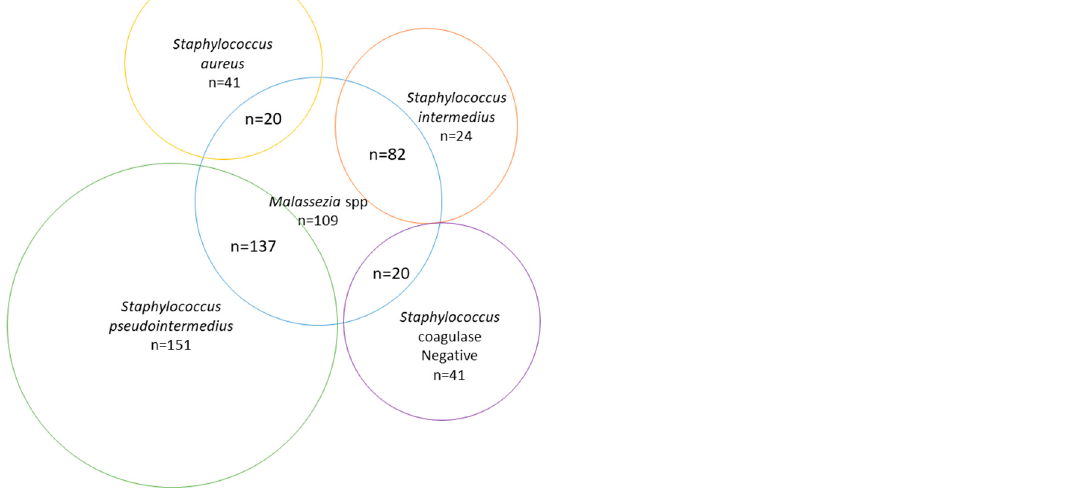
Figure 1. Number of infections by Malassezia spp . and Staphylococcus spp isolated from skin and ear samples in dogs between 2016 and 2019.